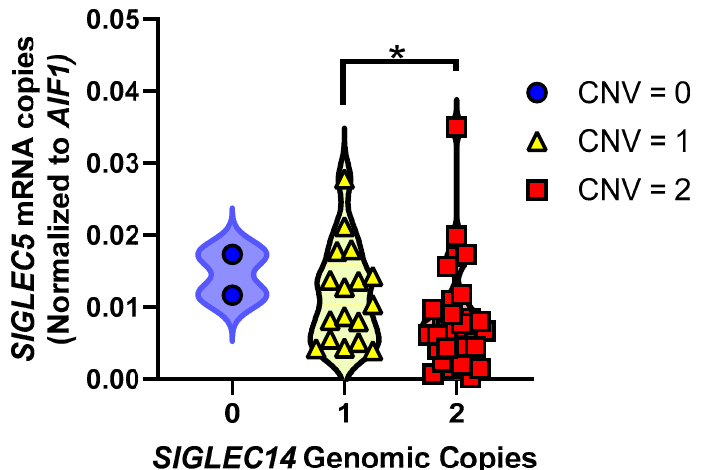
Figure 4. SIGLEC5 expression inversely correlates with SIGLEC14 CNV. SIGLEC5 expression increases with fewer copies of SIGLEC14 , presumably due to proximity to regulatory elements ( p = 0.0220, F 2,46 = 4.151), Tukey’s post-hoc multiple comparisons test. * p = 0.0389.